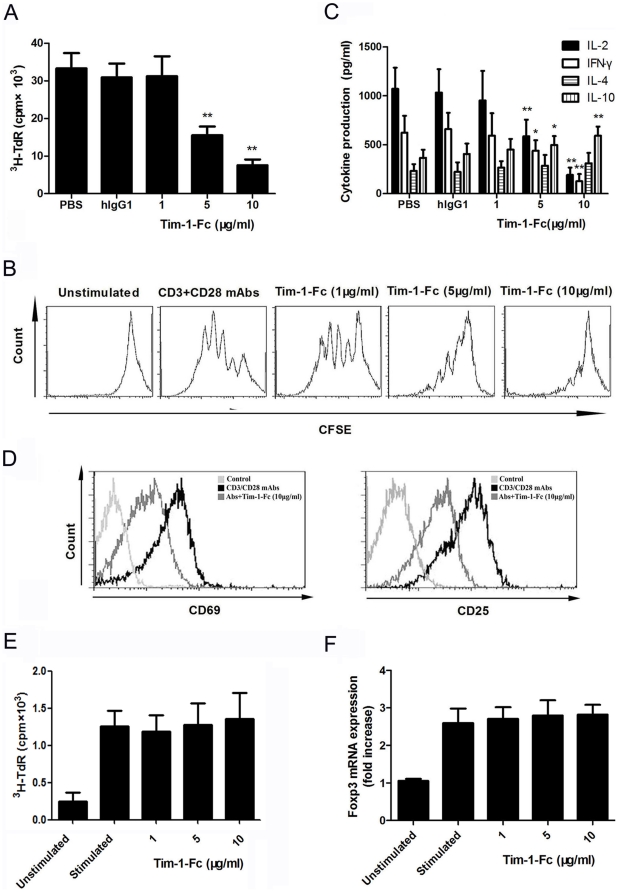
Tim-1-Fc inhibits the activation and proliferation of Teffs but not nTergs.Splenic CD4+ T cells (2×105/well) were purified from C57BL/6 mice and were stimulated by anti-CD3 (2 µg/ml) and anti-CD28 (1 µg/ml) mAbs in the presence of Tim-1-Fc (1, 5, 10 µg/ml) or control PBS or hIgG1 for 72 h. Proliferation was measured by 3H thymidine uptake (A) and CSFE (B). Supernatants were obtained for cytokine ELISA (C). CD4+ T cells (2×105/well) were stimulated with anti-CD3, anti-CD28 mAbs or together with Tim-1-Fc (10 µg/ml) in 96-well plates for 48 h, then were harvested to stain with anti-CD69, CD25-PE and analyzed by FCM. Data were representative of three experiments (D). Freshly isolated CD4+CD25+ regulatory T cells were stimulated with anti-CD3, anti-CD28 mAbs (100 ng/ml for each) and IL-2 (200 IU/ml) in the presence of Tim-1-Fc (1, 5, 10 µg/ml) for 72 h, the proliferation and Foxp3 expression of nTregs were assessed by 3H thymidine incorporation (E) or RT-PCR (F). *P<0.05, **P<0.01 in comparison with controls.